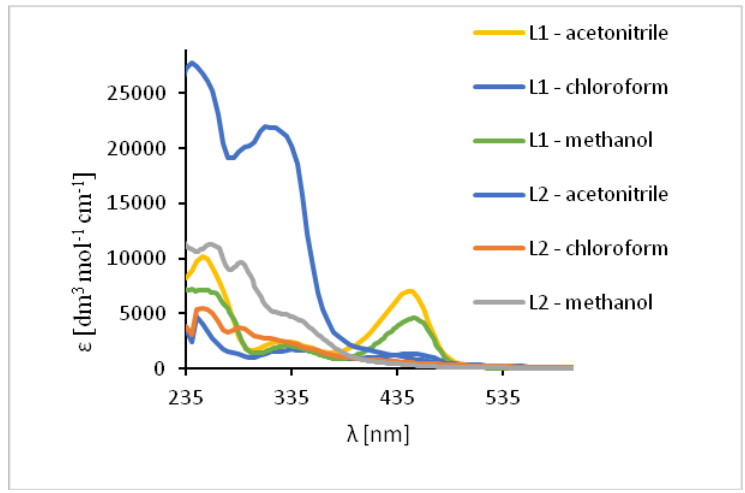
Figure 7. Solution absorption spectra of ligands in chloroform, acetonitrile and methanol, 1 × 10 −4 mol/dm 3 , RT).